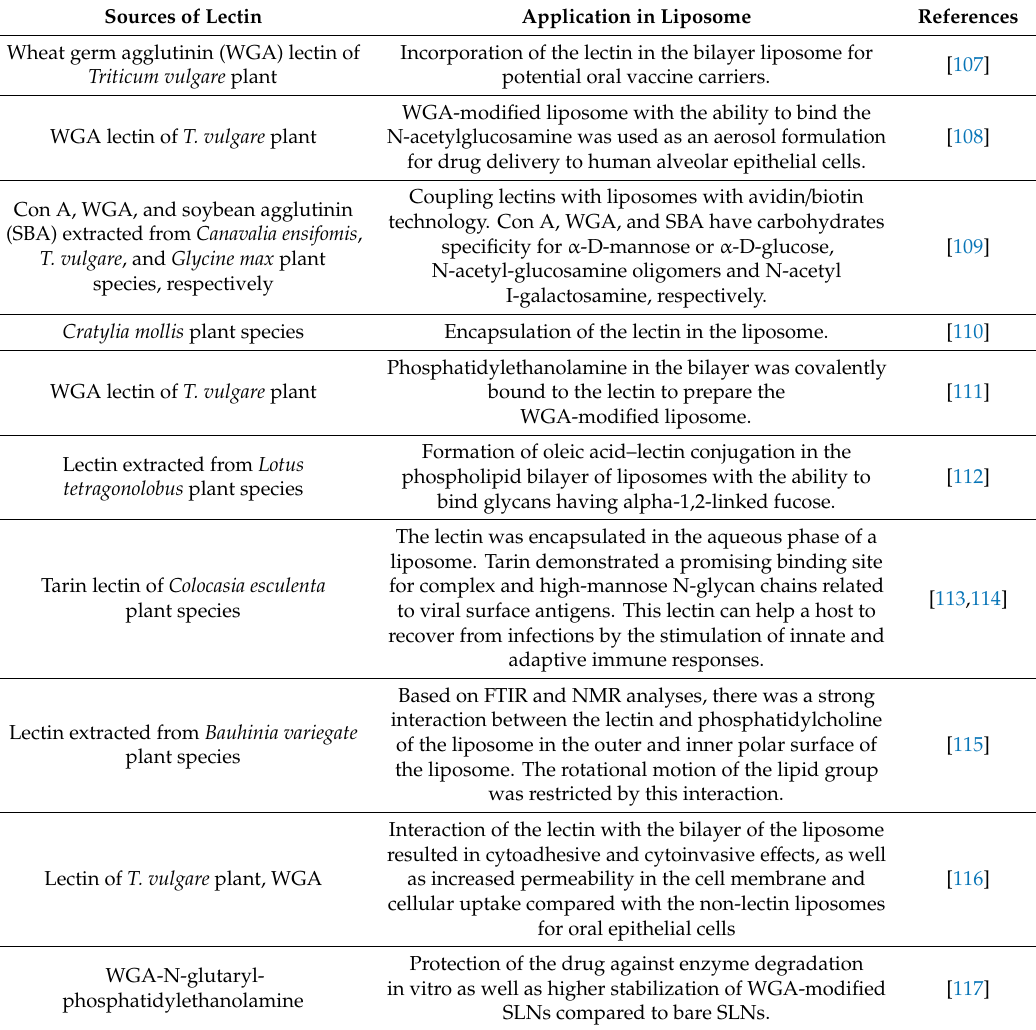
Table 1. Applications of several types of lectin in liposome